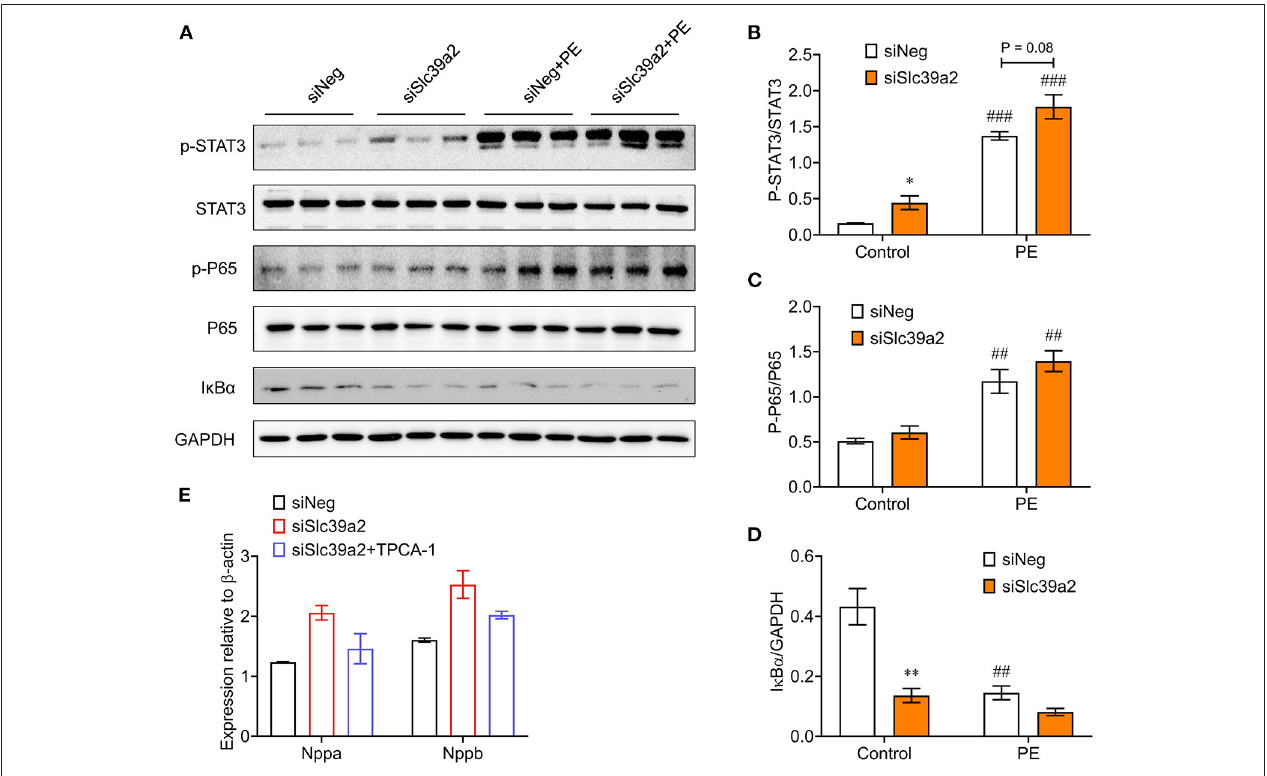
FIGURE 6 | Slc39a2 deficiency enhances I κ B α degradation and NF κ B/STAT3 phosphorylation. (A) Immunoblots of phosphorylated STAT3, total STAT3, phosphorylated P65, total P65, I κ B α , and GAPDH in siNeg- or siSlc39a2-transfected NRVMs with and without PE treatment. (B-D) Quantification data of p-STAT3/STAT3 ratio (B) , p-P65/P65 ratio (C) , and I κ B α /GAPDH ratio (D) . * P < 0.05, ** P < 0.01 vs. siNeg; ## P < 0.01, ### P < 0.001 vs. Control. n = 3. (E) Impact of TPCA-1, an inhibitor of NF κ B (2 µ M), on Nppa and Nppb expressions in NRVMs with or without Slc39a2 knockdown after PE treatment. n =